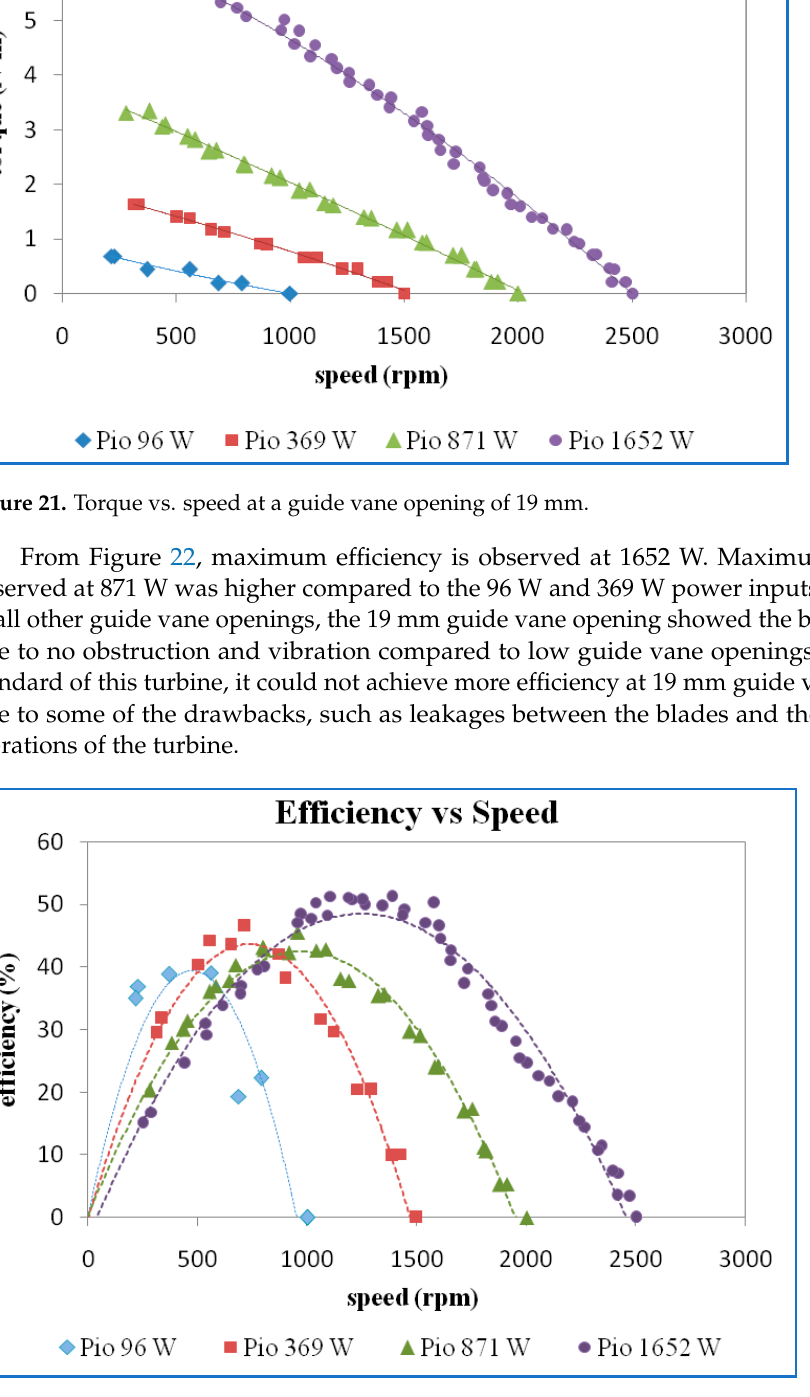
Figure 22. Efficiency vs. speed at a guide vane opening of 19 mm. Discharge was found to be constant as speed was varied at different input